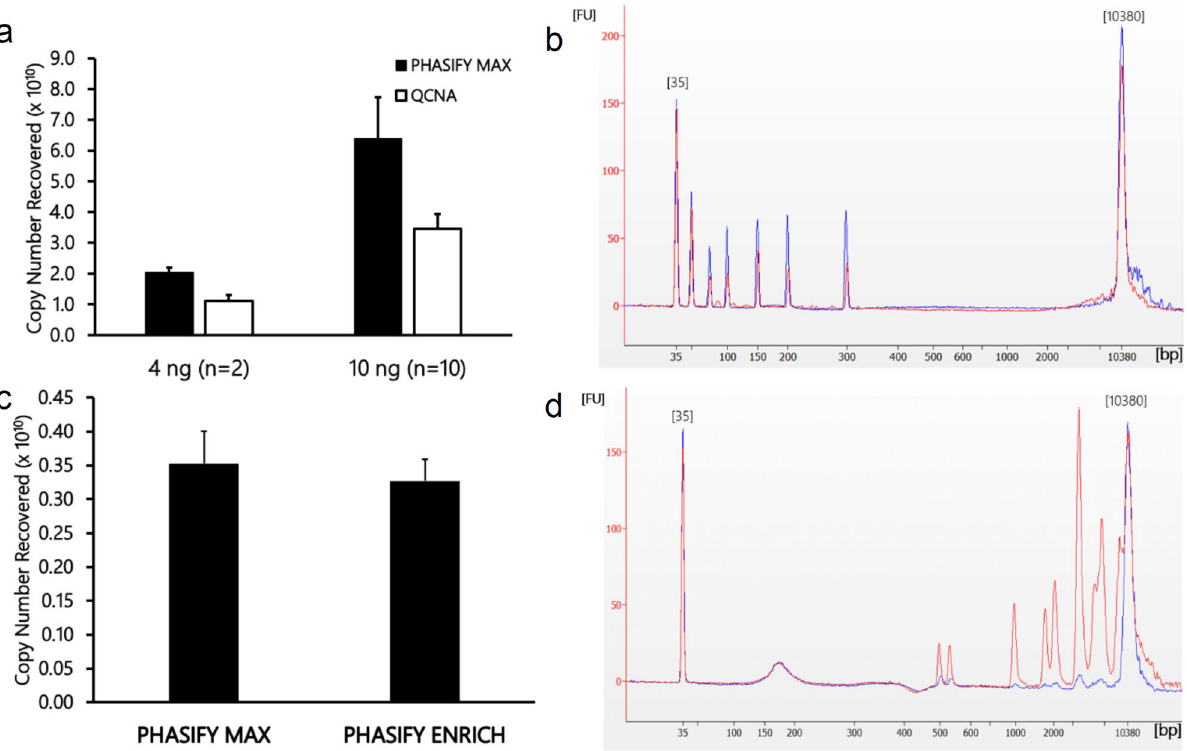
Figure 2. Analytical performance of PHASIFY MAX and ENRICH extraction kits. ( a ) cfDNA recovery of PHASIFY MAX (black bars) was assessed and compared against QCNA (white bars). Four or 10 ng of a synthetic 145 bp dsDNA fragment were spiked into 1 mL healthy human plasma, then processed by both extraction kits. The detection of the recovered cfDNA was performed using Taqman-based probe and primers specific for the 145 bp dsDNA sequence and quantified by ddPCR using a Bio-rad QX200 and QuantaSoft (version 1.7.4; www. bio- rad. com) ( b ) Agilent Bioanalyzer 2100 data demonstrates the ability of both PHASIFY MAX (blue) and QCNA (red) kits to recover all DNA fragment sizes from plasma samples spiked with DNA ladder (50, 75, 100, 150, 200, 300 bp), with PHASIFY-extracted samples obtaining higher peak amplitudes for each fragment size compared to QCNA. ( c ) Contrived samples of 1 ng 145 bp dsDNA spiked into 1 mL of plasma were processed with PHASIFY MAX and PHASIFY ENRICH (n = 3 each). Both kits achieved similar recovery of the 145 bp fragments as detected by ddPCR. ( d ) Plasma spiked with DNA ladder (500 – 10 k bp) were processed with either PHASIFY MAX (red) or PHASIFY ENRICH (blue) extraction kits and the resulting samples were analyzed with an Agilent Bioanalyzer. PHASIFY MAX extracted all fragment sizes contained in the DNA ladder while ENRICH removes larger DNA fragments (> 500